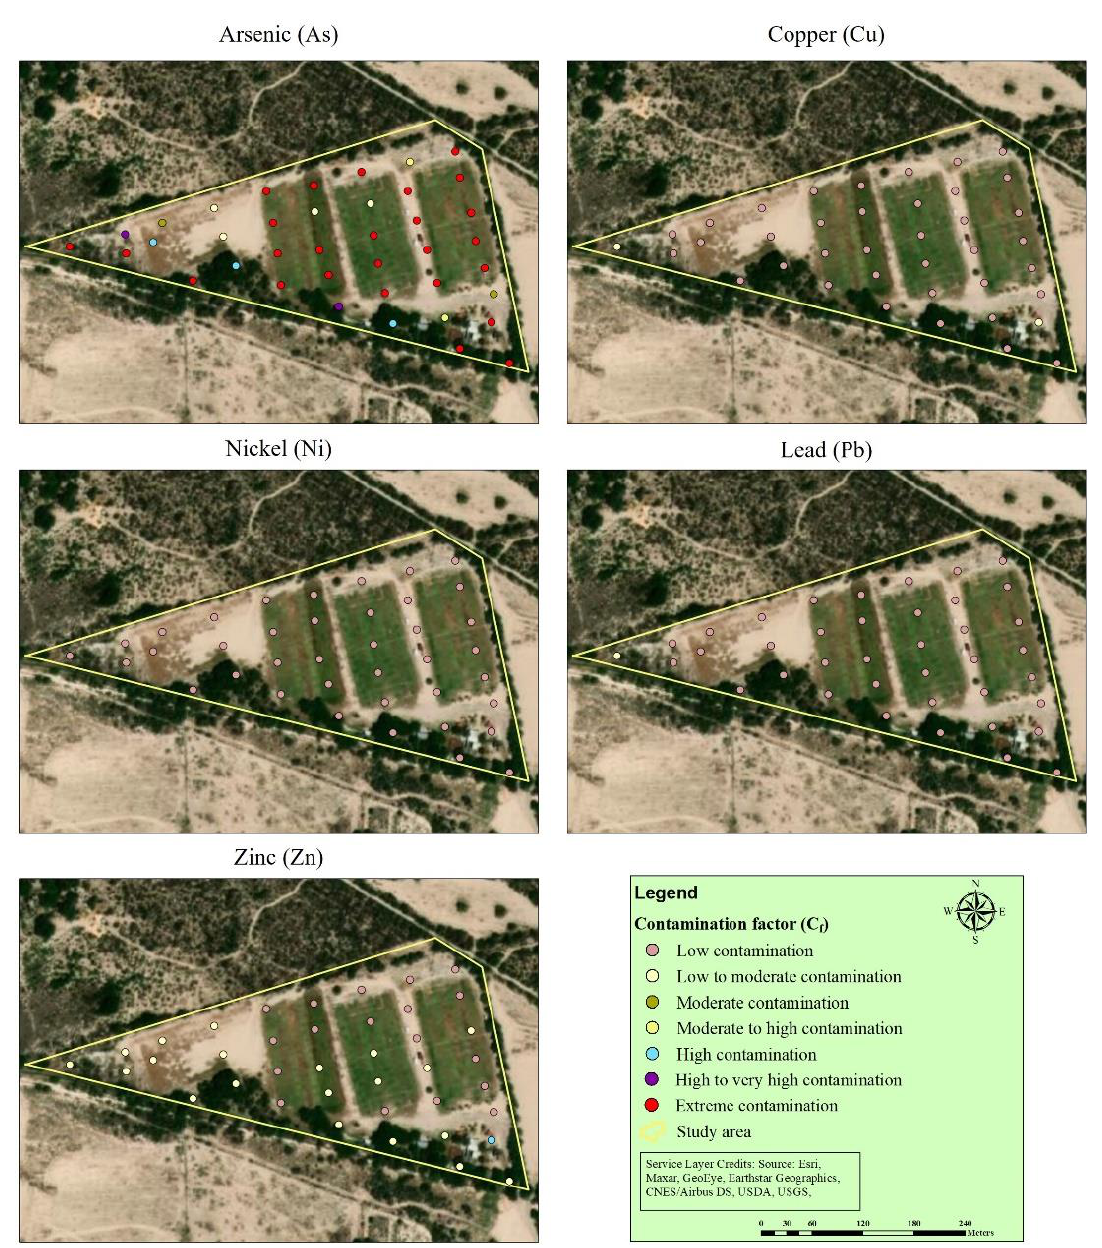
Figure 3. Classifications of the contamination factor ( C f ) for soil sampling locations.